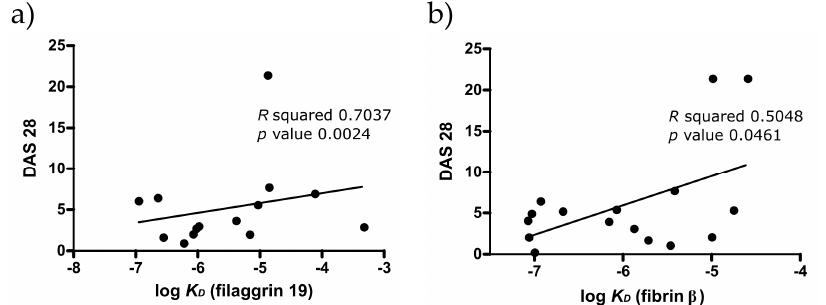
Figure 7. Correlation between the disease severity (DAS28) and the apparent binding affinity ( K D ) of serum antibodies from RA patients, ( a ) measured on filaggrin 19 peptide, ( b ) on fibrin β peptide. 2.5. Selective Depletion of Autoantibody Producing B Cells Ex Vivo by the Multi-Epitope Peptide Covalently Coupled to Poly (Lactic-Co-Glycolic Acid) (PLGA) Nanoparticles (NP)